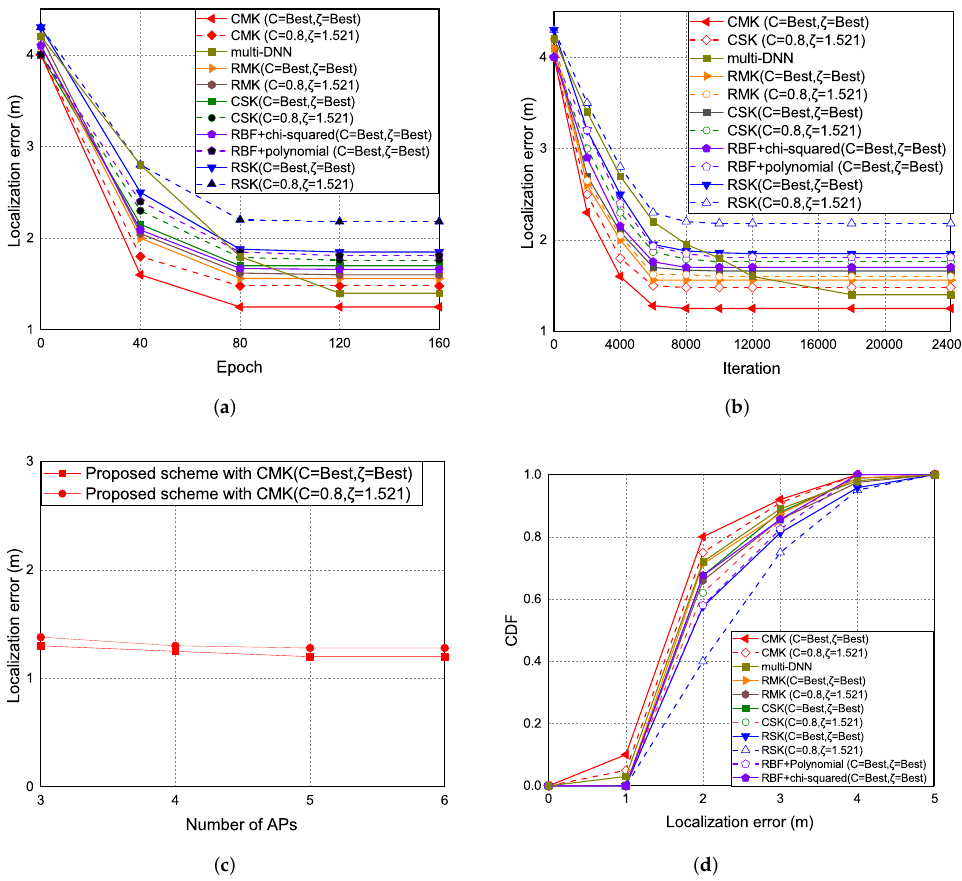
Figure 11. ( a ) Localization error vs. epoch.( b ) Localization error vs. iteration. ( c ) Localization error vs. number of selected APs with epoch 80. ( d ) CDF vs. localization